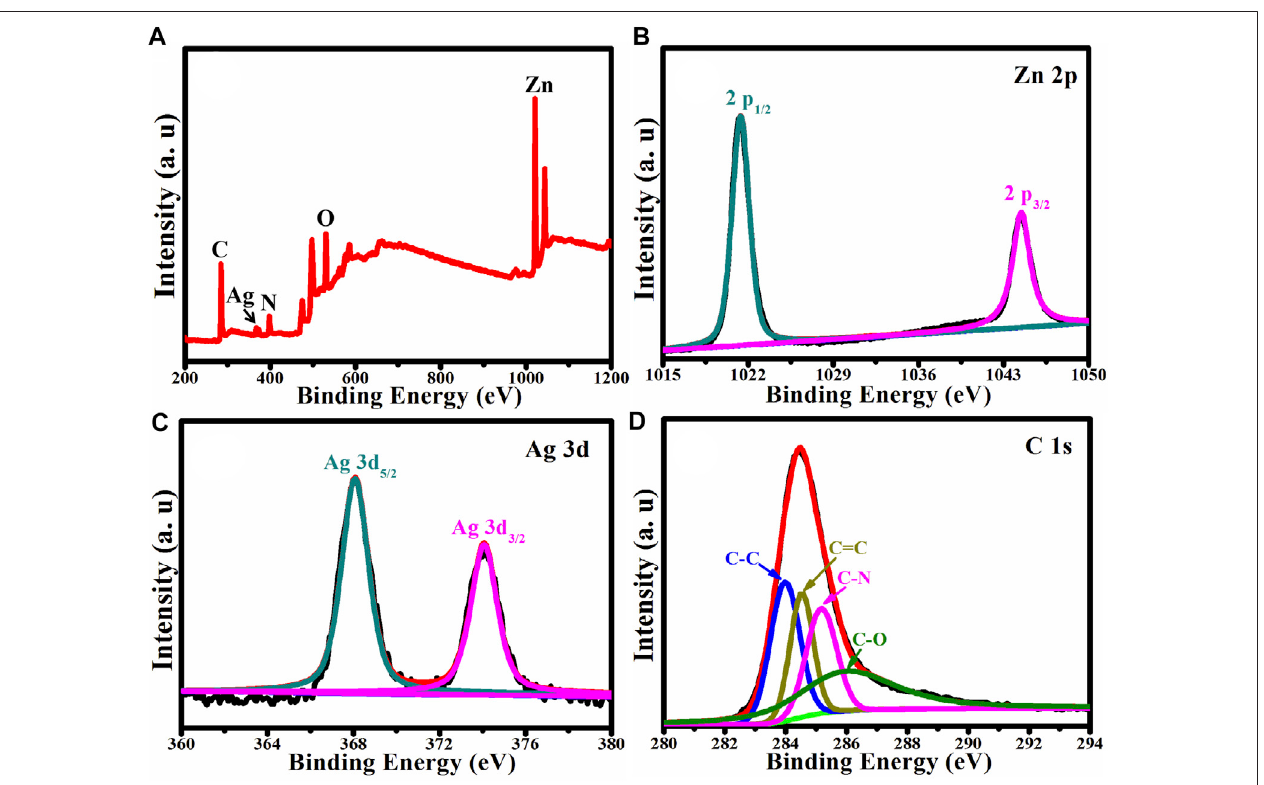
FIGURE 4 | (A) XPS survey spectrum of Ag/ZnO@C and the corresponding high-resolution spectra of (B) Zn 2p, (C) Ag 3d, (D) C 1s.